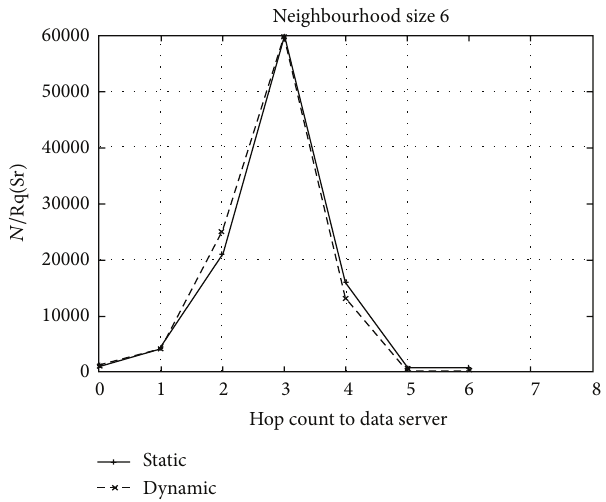
Figure 10: Compare dynamic versus static adjacent list size (6)